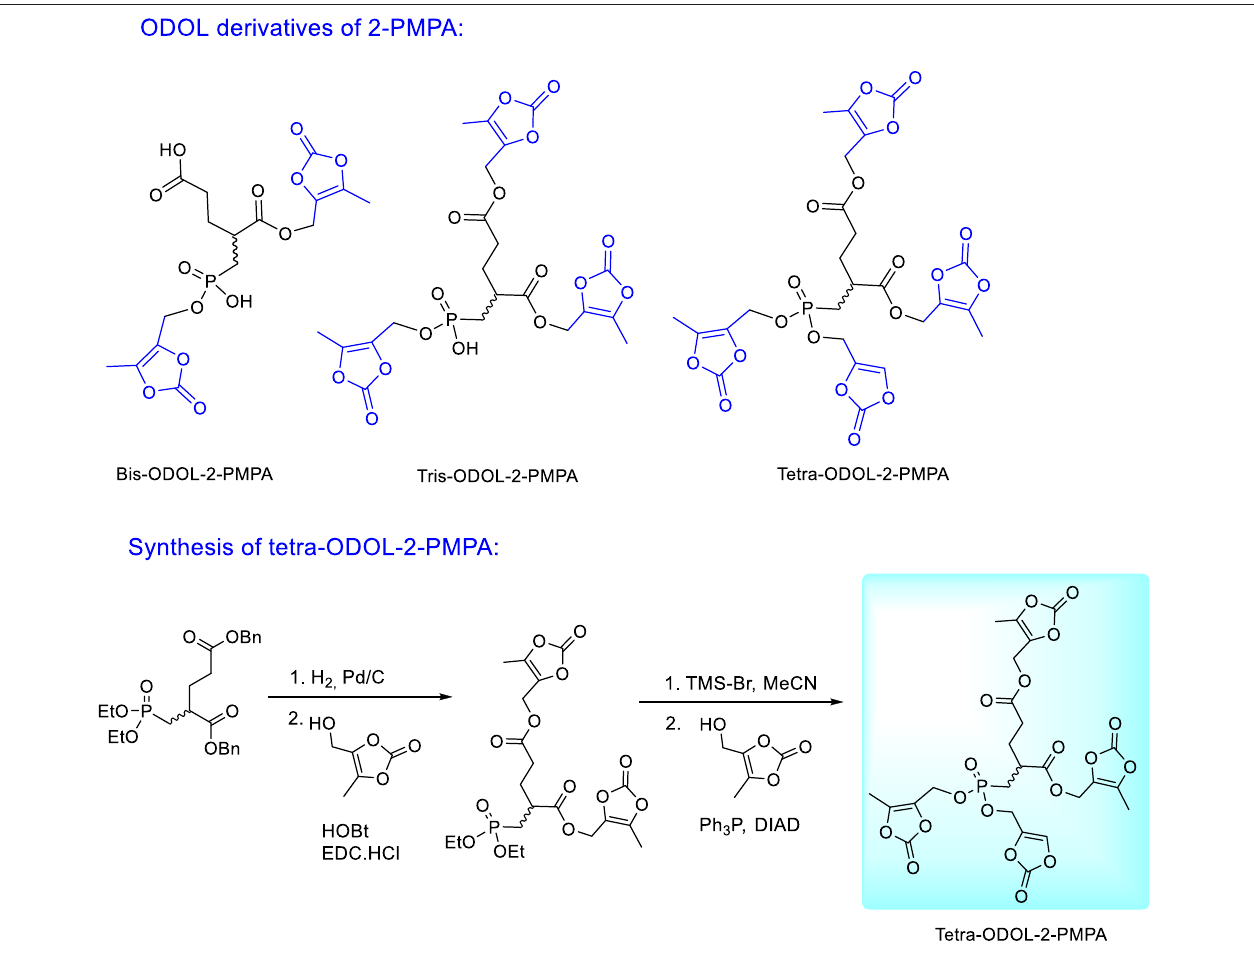
FIGURE 17 | Synthesis and structures of (5-methyl-2-oxo-1,3-dioxol-4-yl)methyl (ODOL) ester prodrugs of 2-PMPA.